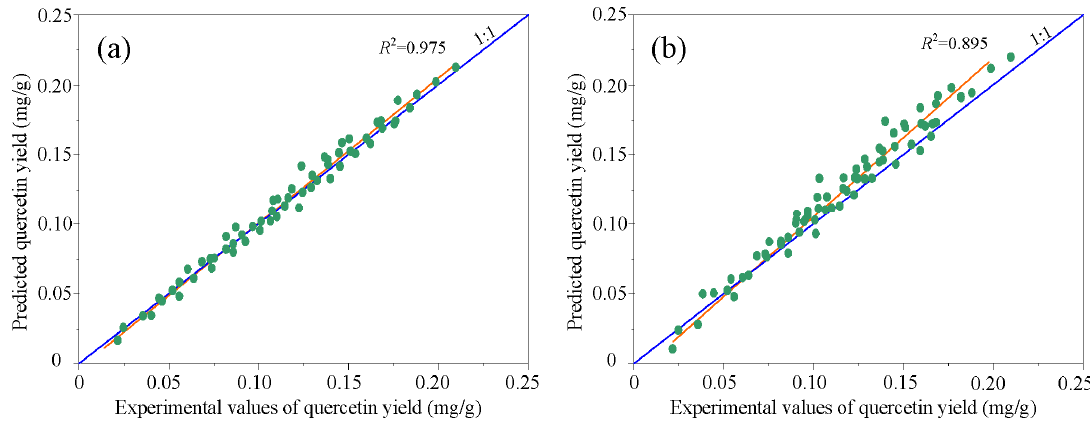
Figure 13. Cross ‐ correlation of predicted and experimental values of quercetin yield for: IFOA ‐ LS ‐ SVM model ( a ); and multiple regression (MR) model ( b ).